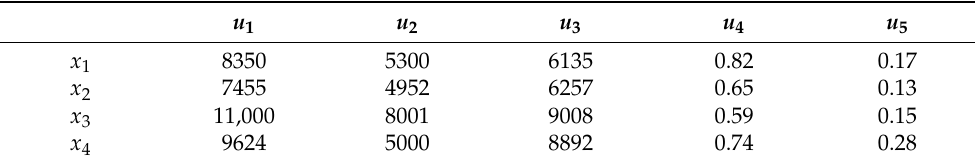
Table 1. Decision